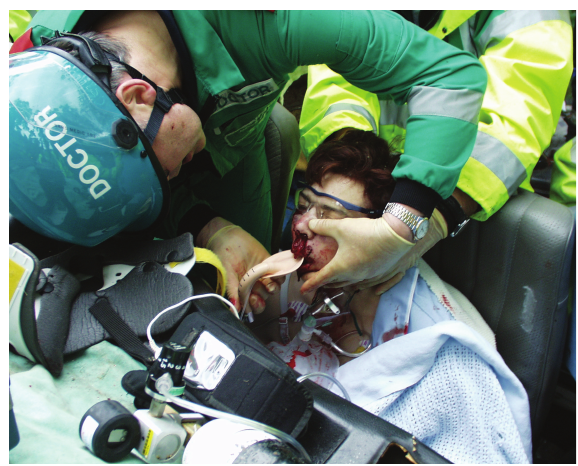
Figure 2: Insertion of the iLMA with manual in-line axial stabilisation of the cervical spine applied by an assistant (image shown with the full informed consent of the patient (Case